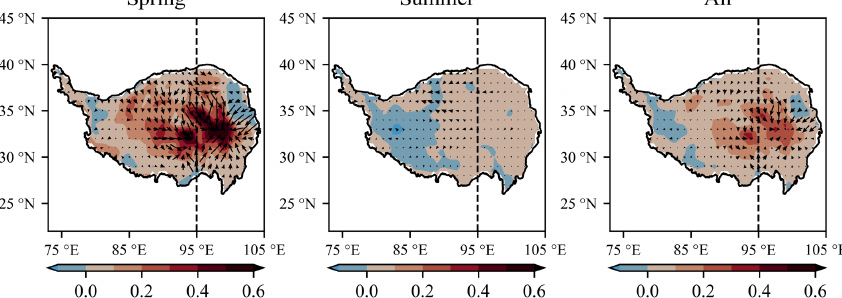
Figure 9. The spatial differences in 10m horizontal wind field (ms − 1 ) between the two ensemble reforecasts (the DA reforecasts minus the control reforecasts). The shaded contours are wind